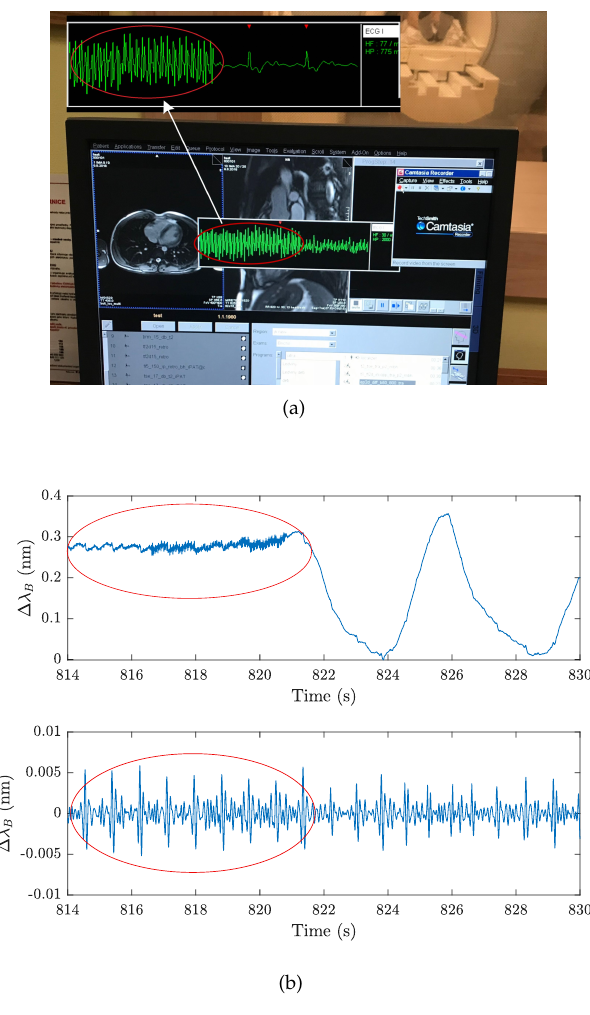
Figure 17. ( a ) An example of ECG signal interference in DWI MRI sequences, ( b ) An example of a signal obtained from the FBG sensor before and after filtering.